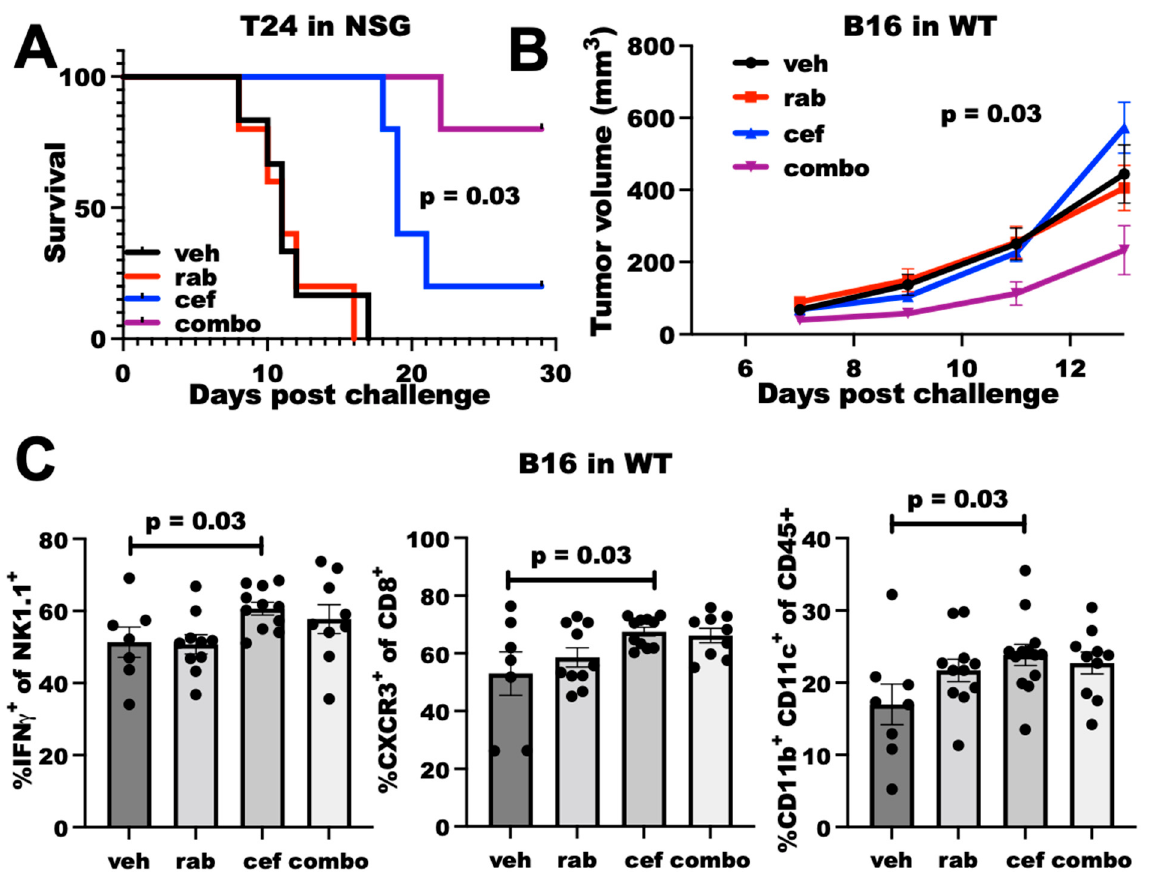
Figure 4. Cefepime elicits PDL1-dependent rabusertib sensitivity in vivo and skews towards TH1. ( A ) Survival of NSG mice ( n = 5 per group) challenged with T24 cells. Mice were treated beginning Day 7 with vehicle (veh), 200 mg/kg cefepime (cef), and/or 2.5 mg/kg rabusertib (rab) daily. p value by log-rank test. ( B ) Tumor growth in WT mice challenged with B16 cells treated with vehicle, 5 mg/kg rabusertib daily, and/or 200 mg/kg cefepime twice daily beginning Day 3 post-challenge. p value by two-way ANOVA. ( C ) Flow cytometry analyses of immune populations in tumors derived from vehicle-, rabusertib-, cefepime-, and combination (combo)-treated mice. p values by unpaired t test.